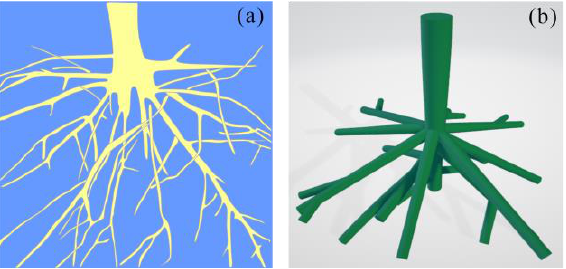
Figure 3. Root system morphology of Houpoea officinalis and its corresponding 3D model. ( a ) root system photograph, ( b ) 3D model.